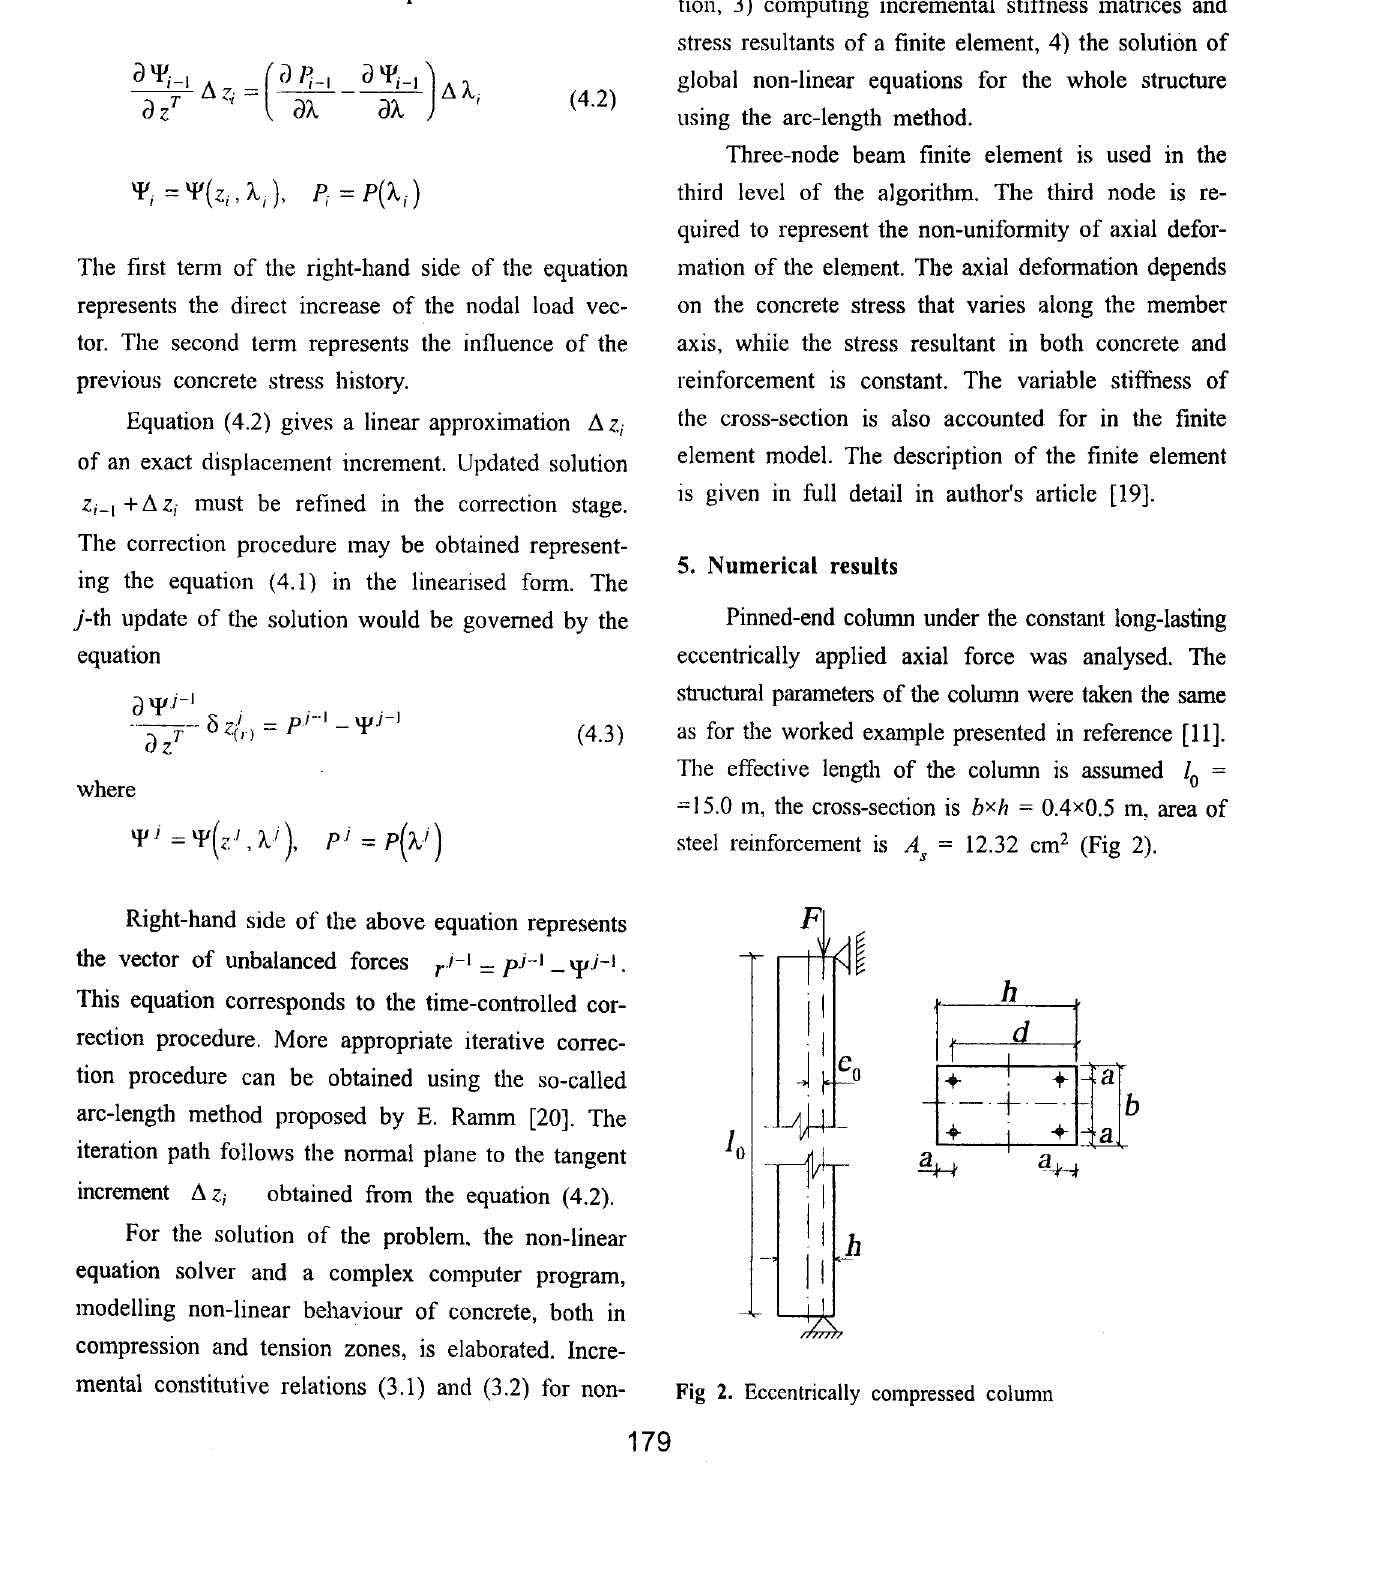
Fig 1. The critical time of the non-linear system the prediction stage, the displacement increment will be obtained from the matrix equation